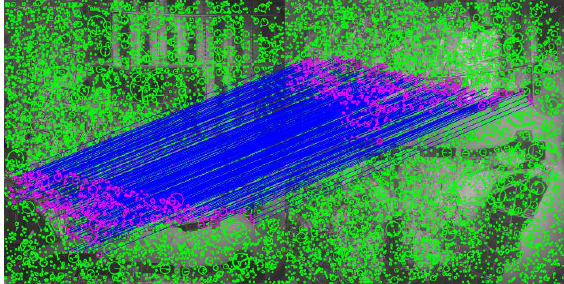
Figure 13. RANSAC result of Case 2.